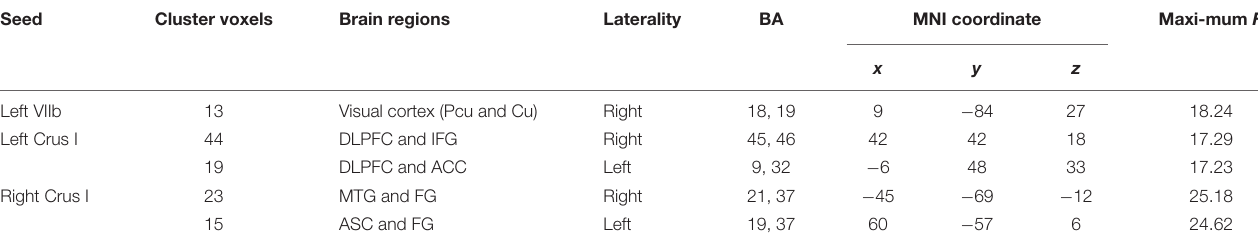
TABLE 2 | Brain regions showing significant differences during one-way ANOVA on z value of functional connectivity maps of NC, aMCI, and AD groups. Seed Cluster voxels Brain regions Laterality